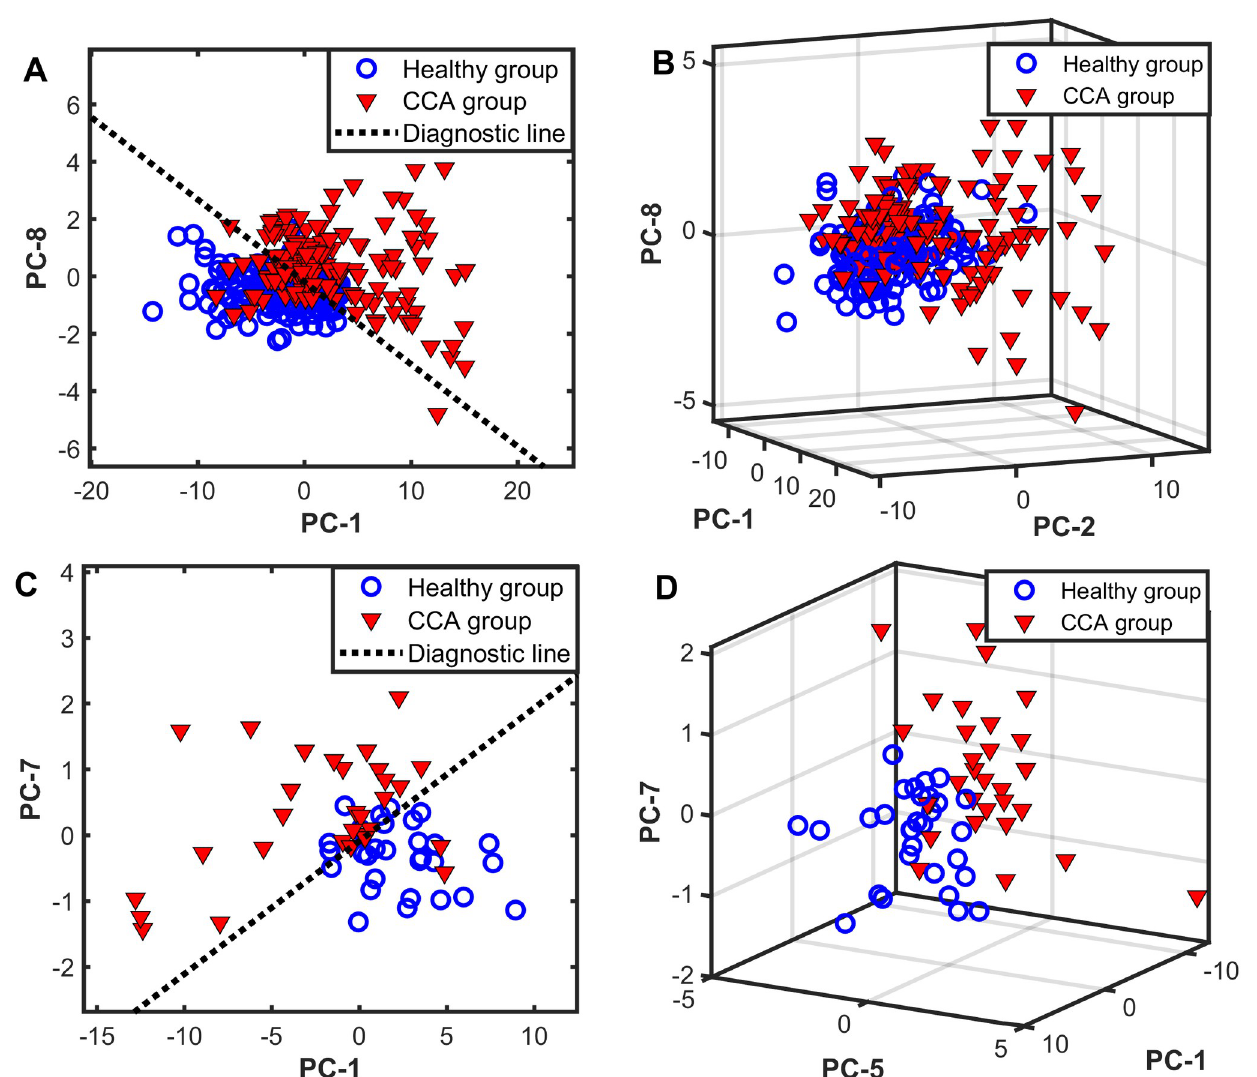
Fig 4. PCA score scatter plots of the healthy group (n = 30, blue) versus cholangiocarcinoma patients (n = 30, red). Before the PCA analysis, each Raman spectrum between 350 and 1800 cm-1 was baseline-subtracted and normalized. A and B panels display a total data set of 150 measurements for each group (30 specimens, each measured independently five times). C and D panels display an averaged data set obtained from averaging the five independent measurements of each specimen. The dotted line is a diagnostic line separating the two groups: (A) PC8 = -0.28PC1-0.19 and (C) PC7 = 0.20PC1-0.09.